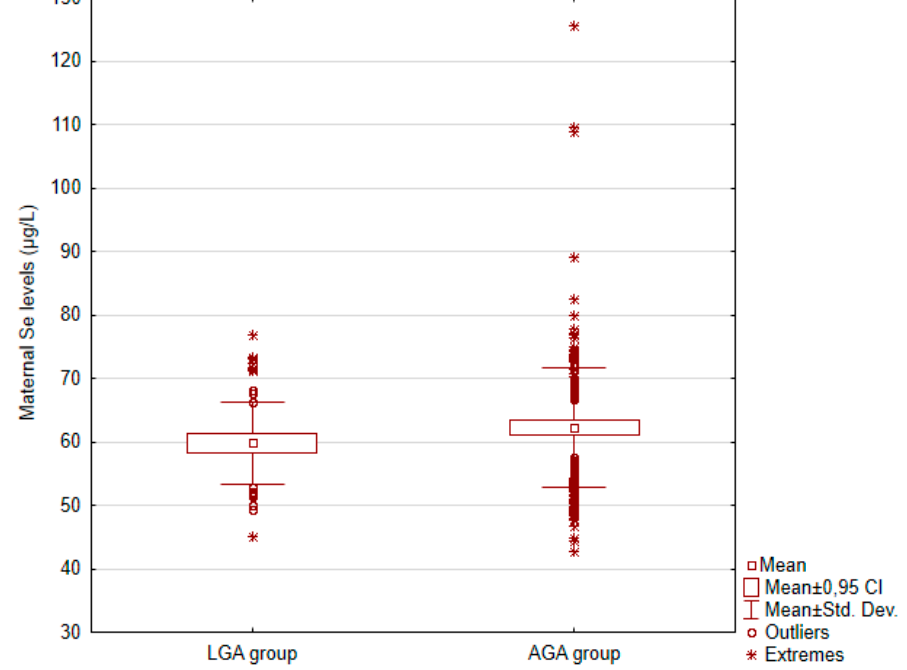
Figure 1. Box and whisker plots for maternal selenium concentrations in the LGA and AGA group, in the whole group; CI: confidence intervals (95%); Std. Dev.: standard deviation.